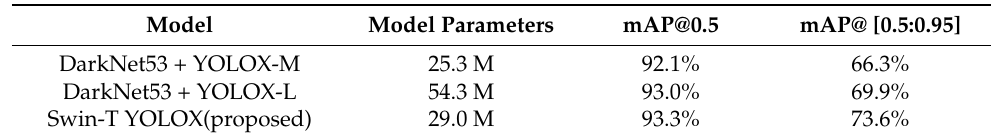
Table 2. Performance comparison of the YOLOX models of different backbone networks in the UAV patrol orchard anomaly detection.